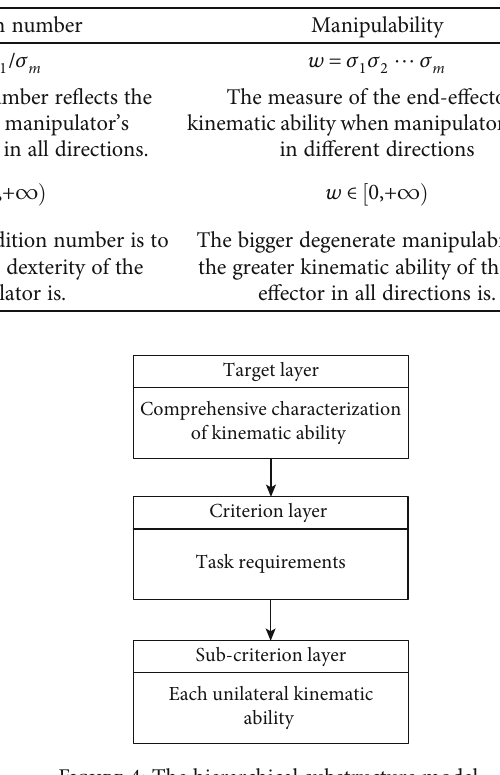
Table 3: The unilateral kinematic ability of the space manipulator with a joint-locked failure.